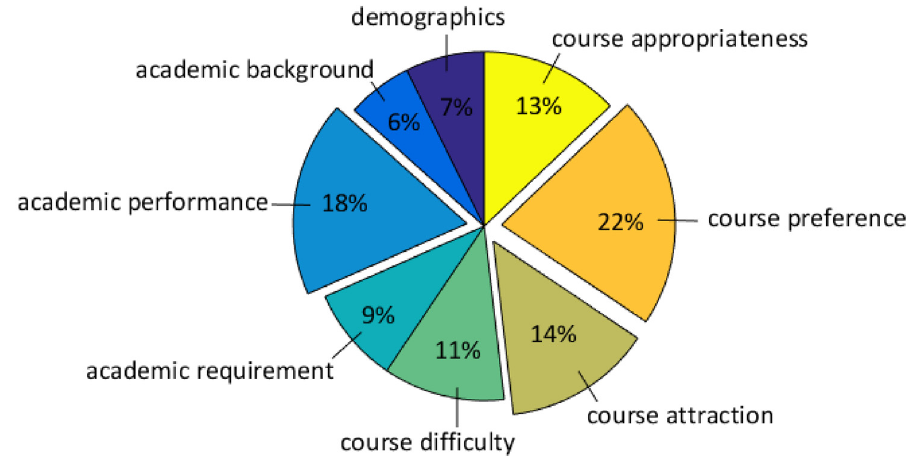
Fig 9. Pie chart of FIMs on the feature categories.